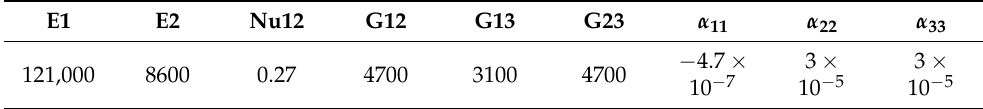
Table A2. UD composite stiffness properties [MPa].